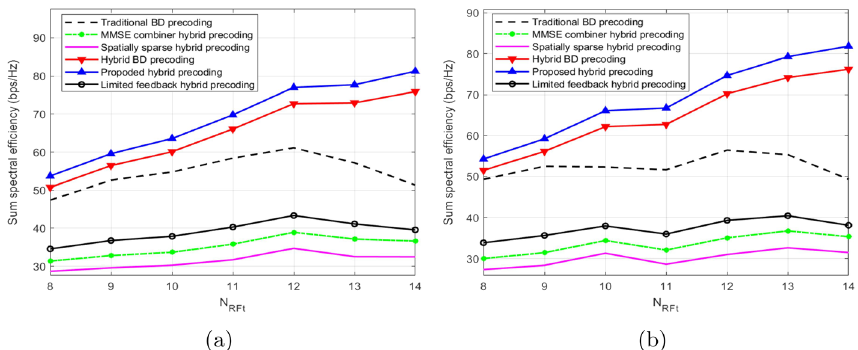
Fig. 5 Achievable spectral efficiency comparison against the number of RF chains in ( a ) mmWave channel; ( b ) Rayleigh